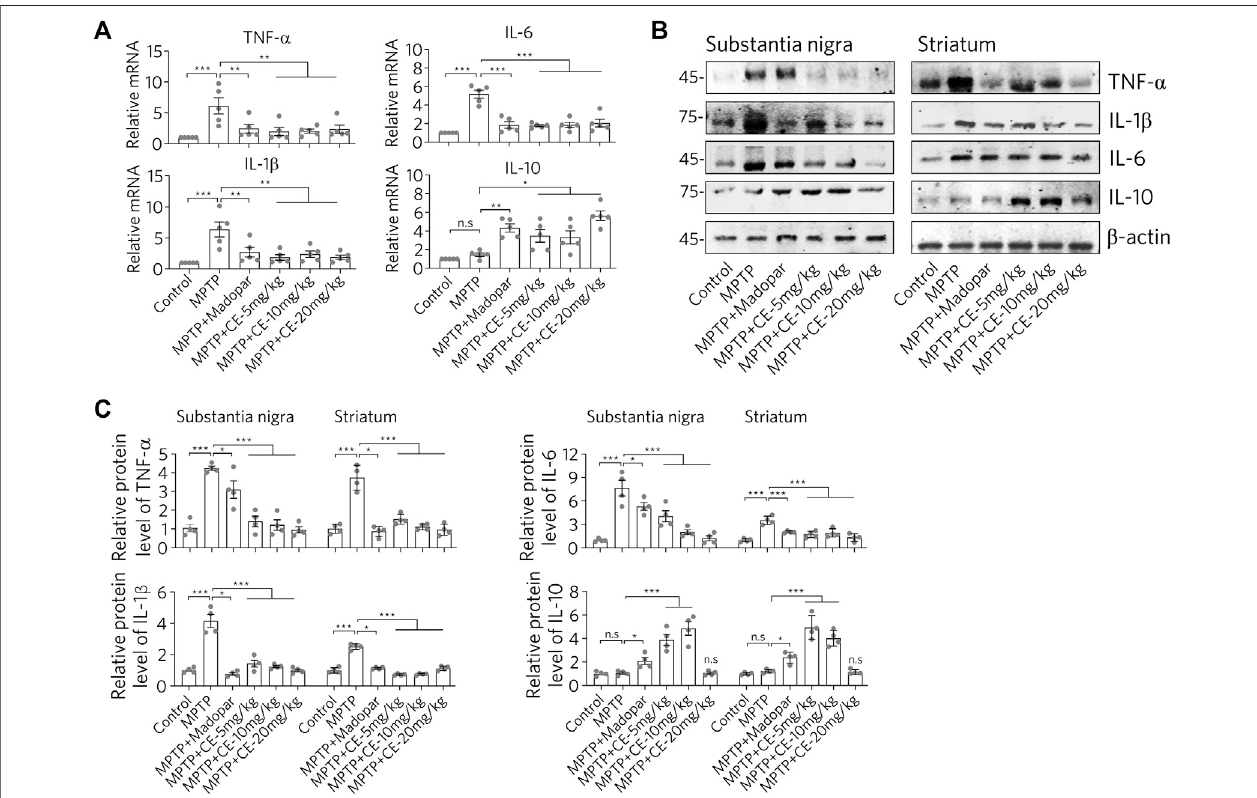
FIGURE 4 | CE restores elevated levels of pro-in fl ammatory factors. (A) RT-PCR determination of mRNA levels of pro-in fl ammatory factors in substantia nigra, n = 5. (B) Western blotting analysis of pro-in fl ammatory factors and anti-in fl ammatory factor IL-10. (C) Relative protein levels normalized to β -actin, n = 4. In A and C, one- way ANOVA followed by Dunnett ’ s test were